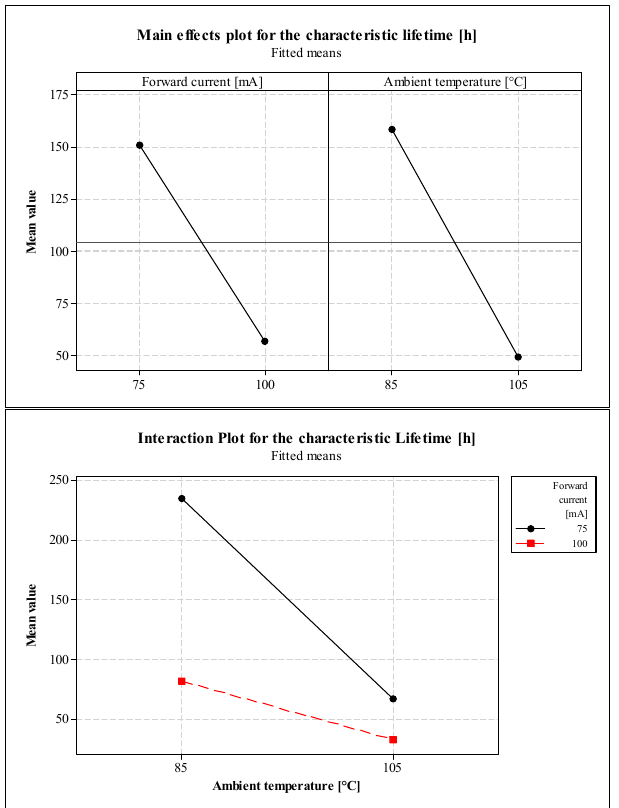
Figure 21. Main effects plot and the interaction plot for the characteristic lifetime.